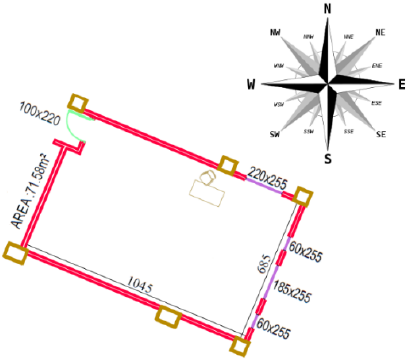
Figure 4. Dimensions (cm) and geographical position of the SCI.